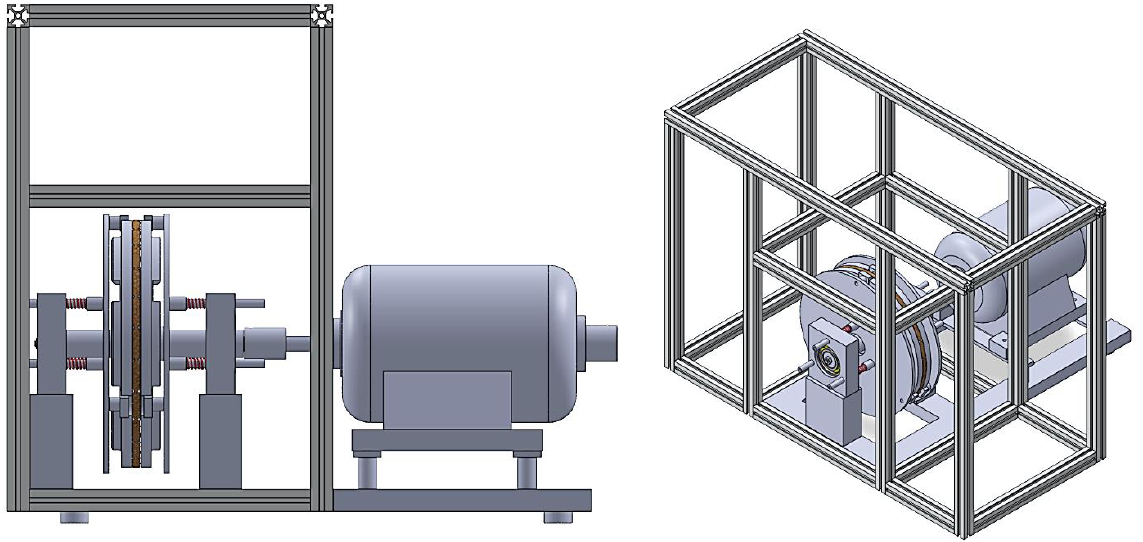
Figure 2. Different views of the clutch tribometer design.